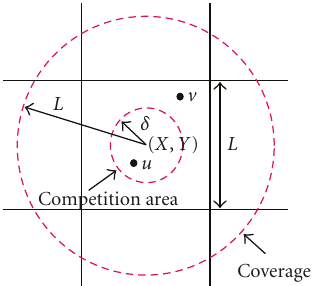
Figure 3: LKE: A virtual grid, with each grid size of L , is computed based on location information. Sensor u is selected from the competition area and will take care of key establishment for nodes residing in the coverage